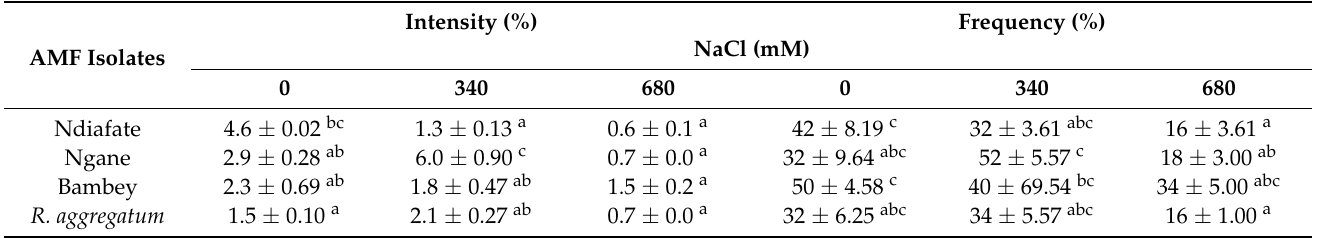
Table 2. Effect of isolates on the mycorrhization of A. seyal seedlings in the presence or absence of NaCl after 30 days of